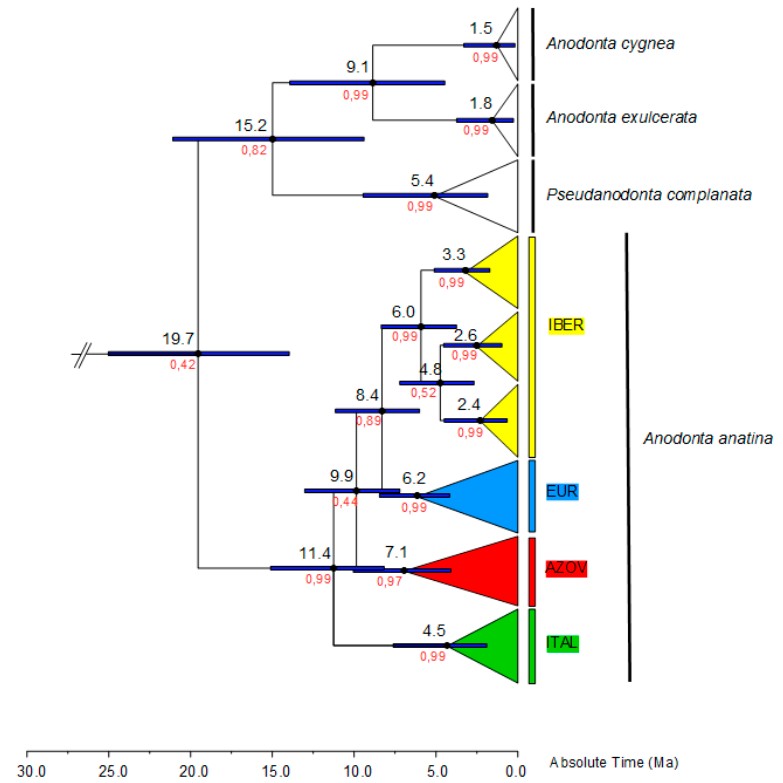
Figure 3. Calibrated phylogenetic tree based on a lognormal relaxed clock model and the Yule process speciation implemented in BEAST 2.1.3 using COI gene sequences of Anodonta and Pseudanodonta . Black numbers near nodes are the mean age values, and bars are 95% confidence intervals of the estimated divergence time between lineages (Ma). Red numbers near nodes are BPP values inferred from BEAST. Sinanodonta woodiana , S. lauta , Unio tumidus , and U. pictorum were used as outgroup (not shown on the tree). The list of sequences is presented in Table S1.